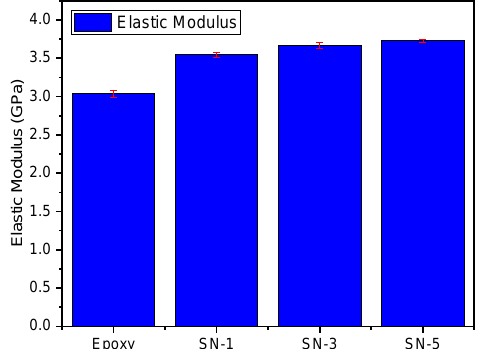
Figure 5. Indentation modulus of SNP formulated epoxy